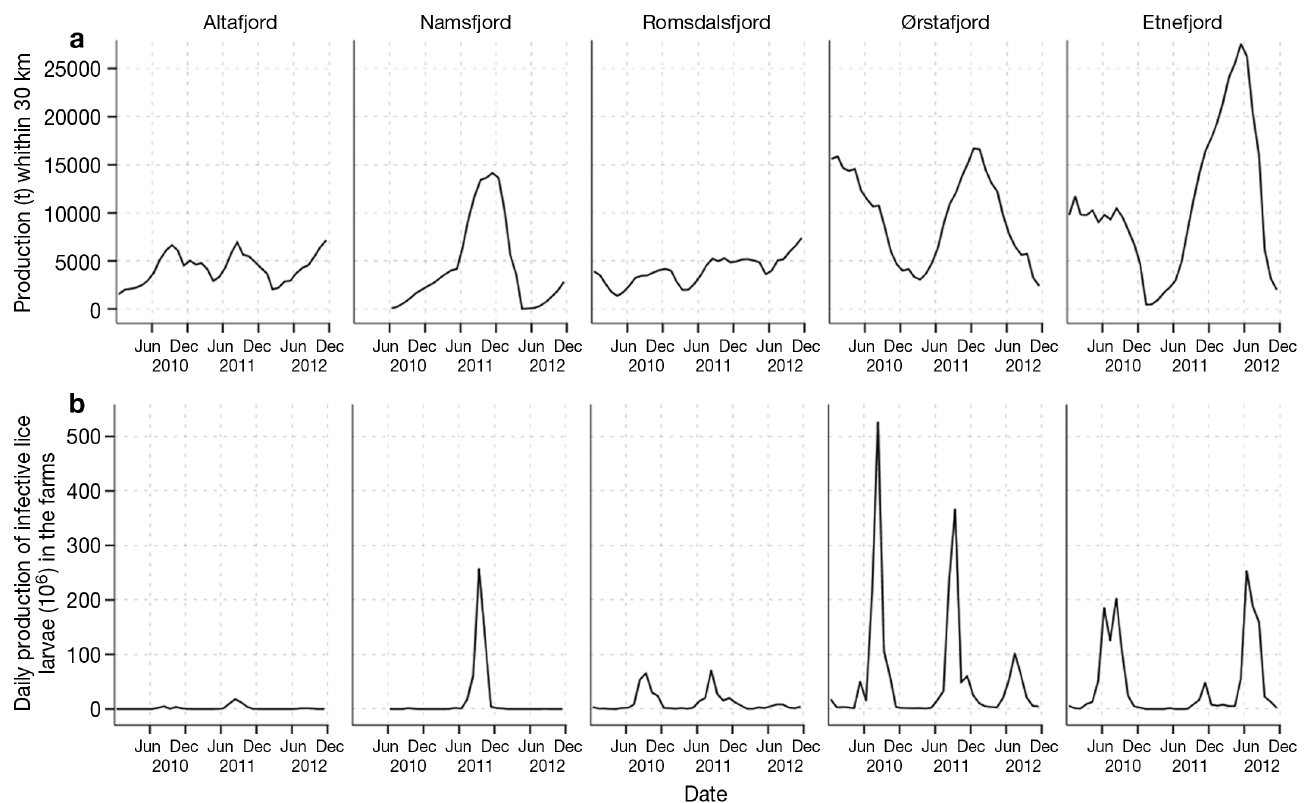
Fig. 2. Production data collected from every salmon and trout farming site situated within 30 km of relevant sea trout sampling locations (inside National Salmon Fjords) between January 2010 and December 2012. (a) Accumulated stocked biomass (t), based on official data reported to the Norwegian Directorate of Fisheries (www.fiskeridir.no). (b) Accumulated daily produc- tion of infective lice larvae (calculated according to Stien et al. 2005 and based on lice counts reported to the Norwegian Food Safety Authorities,